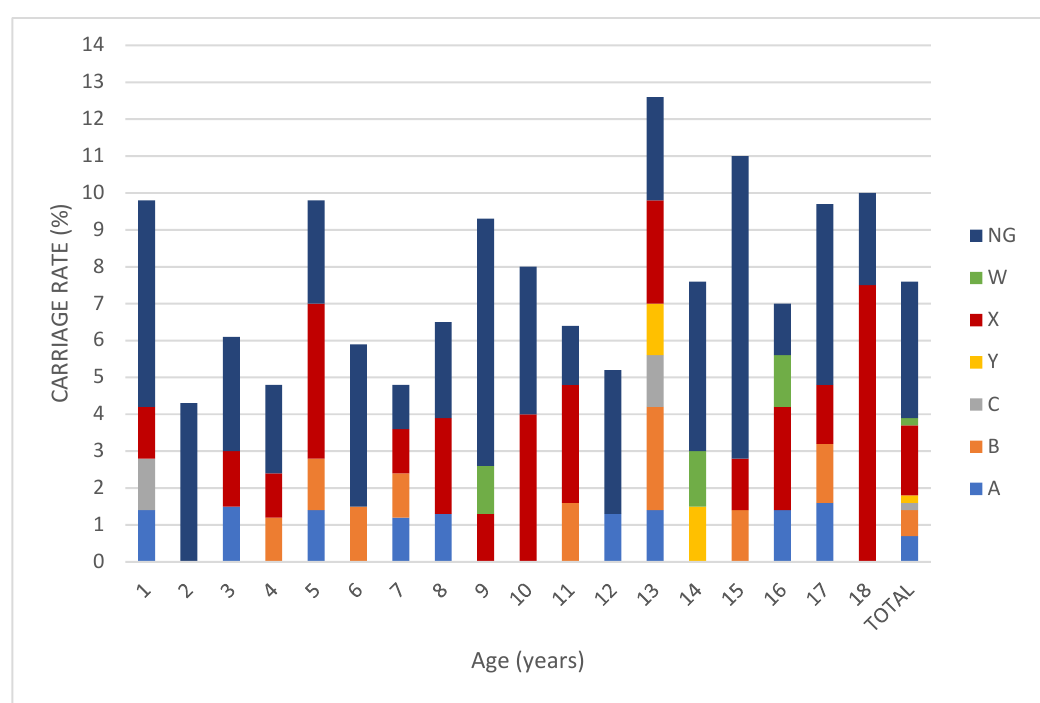
Figure 1. Percentage of meningococcal serogroup carriage among children and adolescents aged between 0 and 18 years old. (NG: non-groupable).